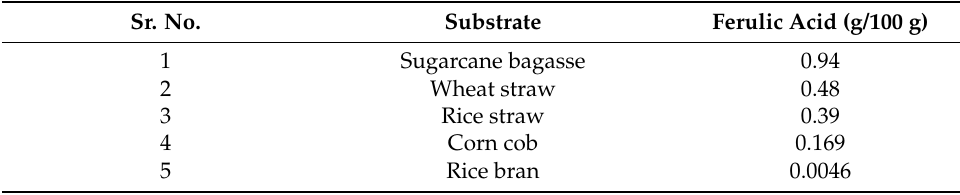
Table 1. Ferulic acid content of different agricultural by-products. Sr. No.